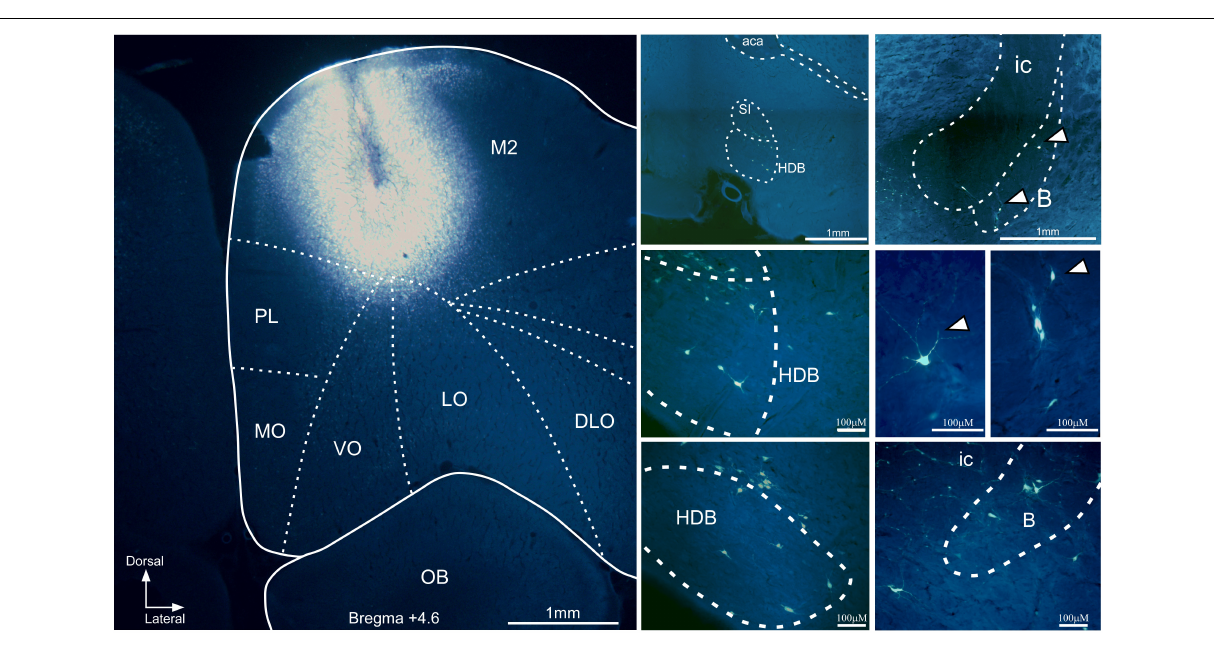
FIGURE 7 | Microphotograph of a coronal section at Bregma +4.6 mm showing the FG injection site in M2 cortex in a representative case (Left) . Microphotographs at different magnifications of coronal sections showing the location of FG labeled neurons found in HDB and in B nucleus (Right) . DLO, dorsolateral orbital cortex; ic, internal capsule; LO, lateral orbital cortex; MO, medial orbital cortex; OB, olfactory bulb; rest of lettering as in Figure 5